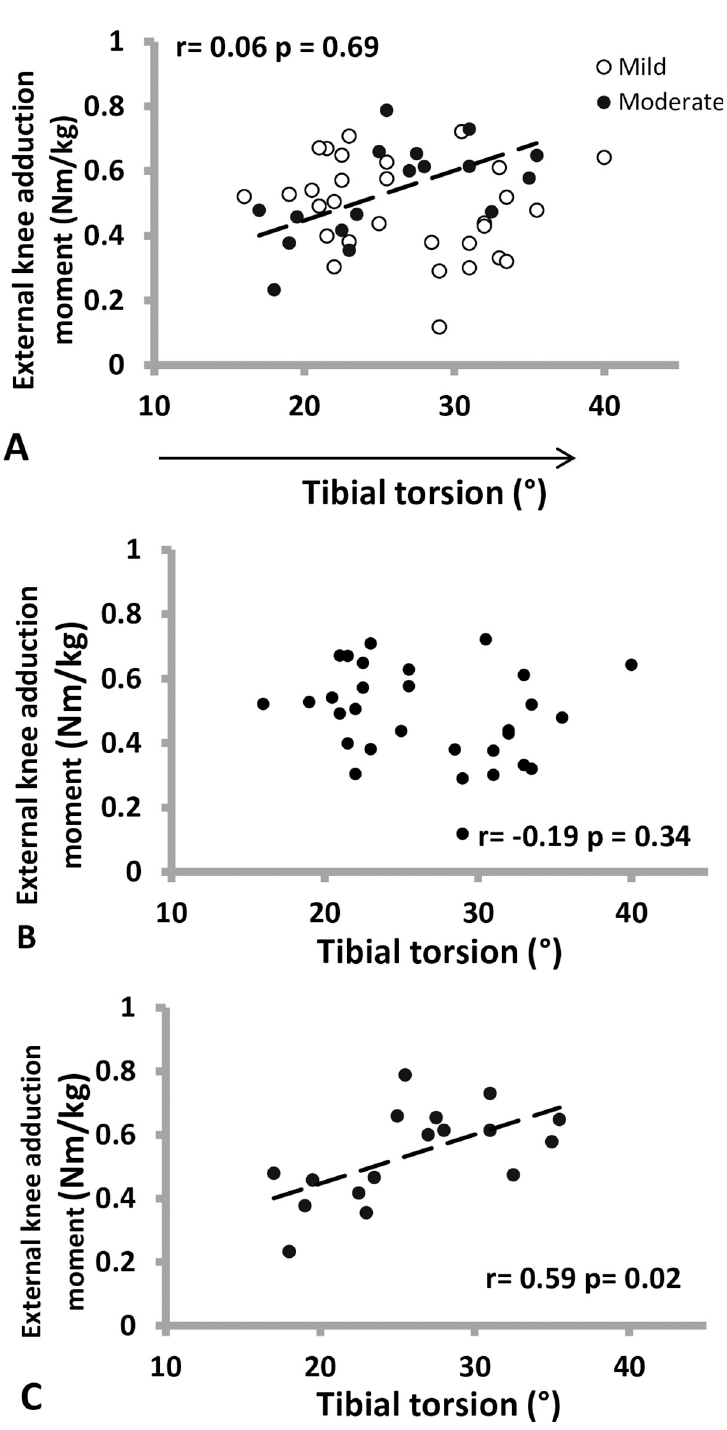
Fig 2. Scatter plots of external knee adduction moment and tibial torsion in different OA severity (A: all subjects, B: mild OA, C: moderate OA).